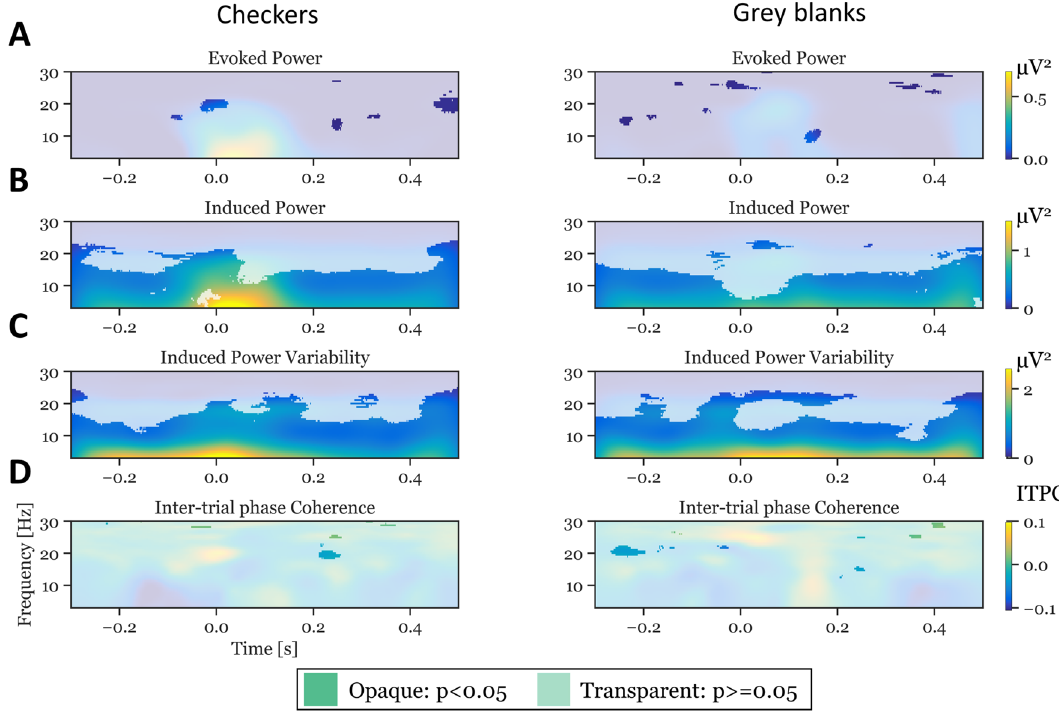
Figure 3. Sources of EEG variability. Column show results for the different stimulus categories checkerboards and gray blanks. Rows show different aspects of time-frequency power and variability. Evoked Power: Time- frequency analysis of ERPs. Induced Power: Time-frequency analysis of induced (i.e., single-trial based) responses. Induced Power Variability: The standard deviation of power values across trials from single-trial time-frequency analyses. Inter-trial phase coherence: An index of phase coherence between trials. Each panel depicts the group difference control group—ASD group. Opaque colors indicate a significant difference at the given time-frequency bin using a Wilcoxon test with an alpha criterion of 0.05. We find that the most consistent differences between groups are reflected in induced responses and their variability, but not in evoked responses or in phase